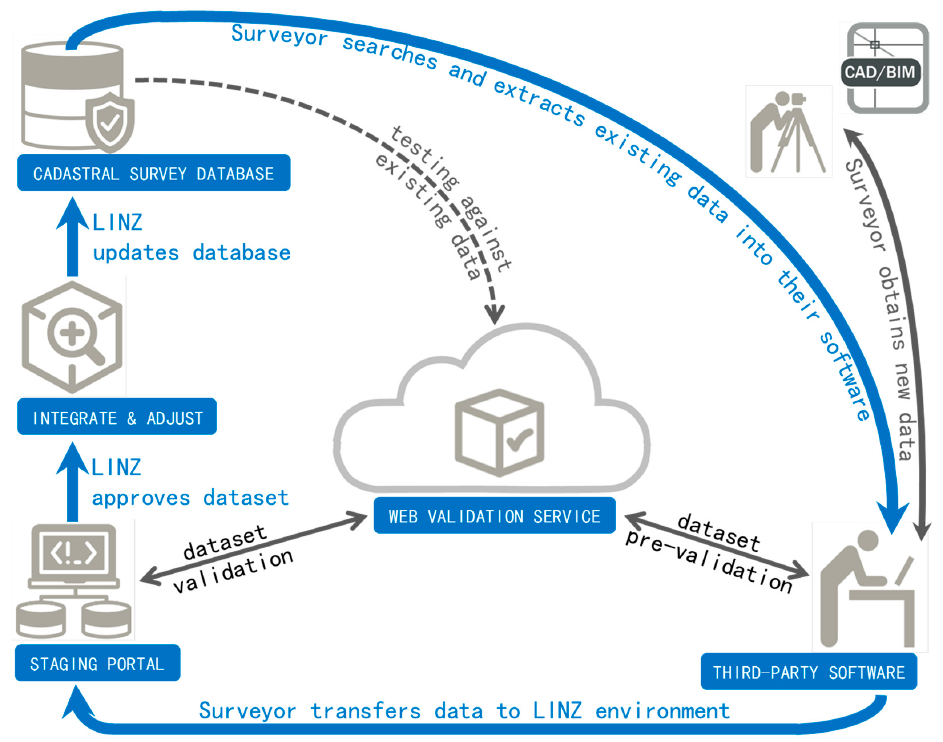
Figure 8. Cycle of Digital Cadastral Survey Data. Note: LINZ denotes Land Information New Zealand.